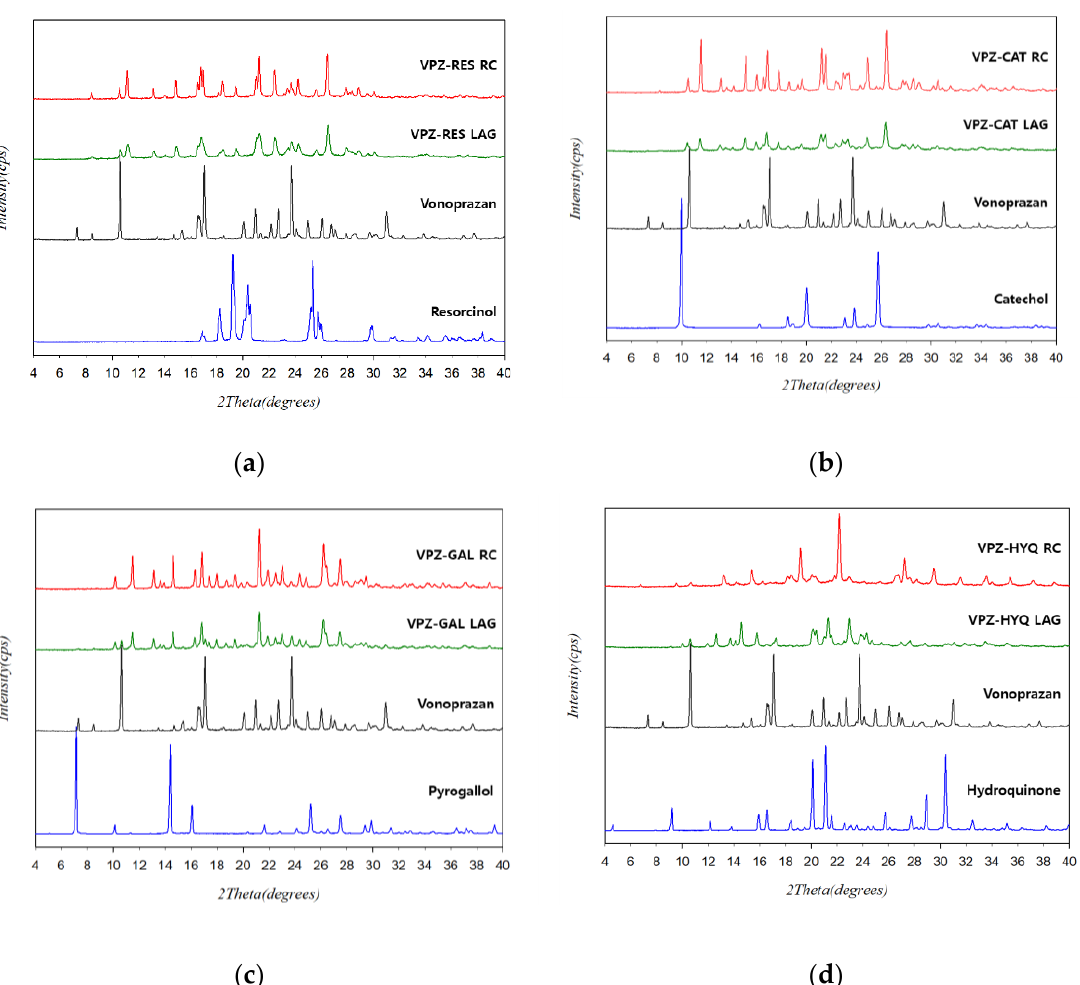
Figure 2. Comparison of the PXRD patterns of ( a ) VPZ-RES, ( b ) VPZ-CAT, ( c ) VPZ-GAL, and ( d ) VPZ-HYQ prepared by RC and LAG with their starting materials.